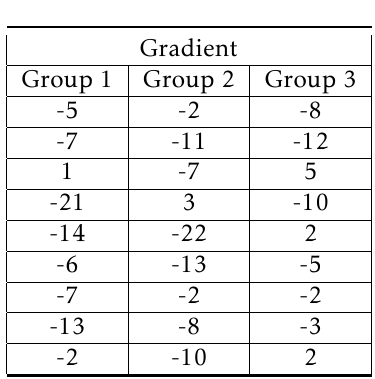
Figure 5. Learning curve